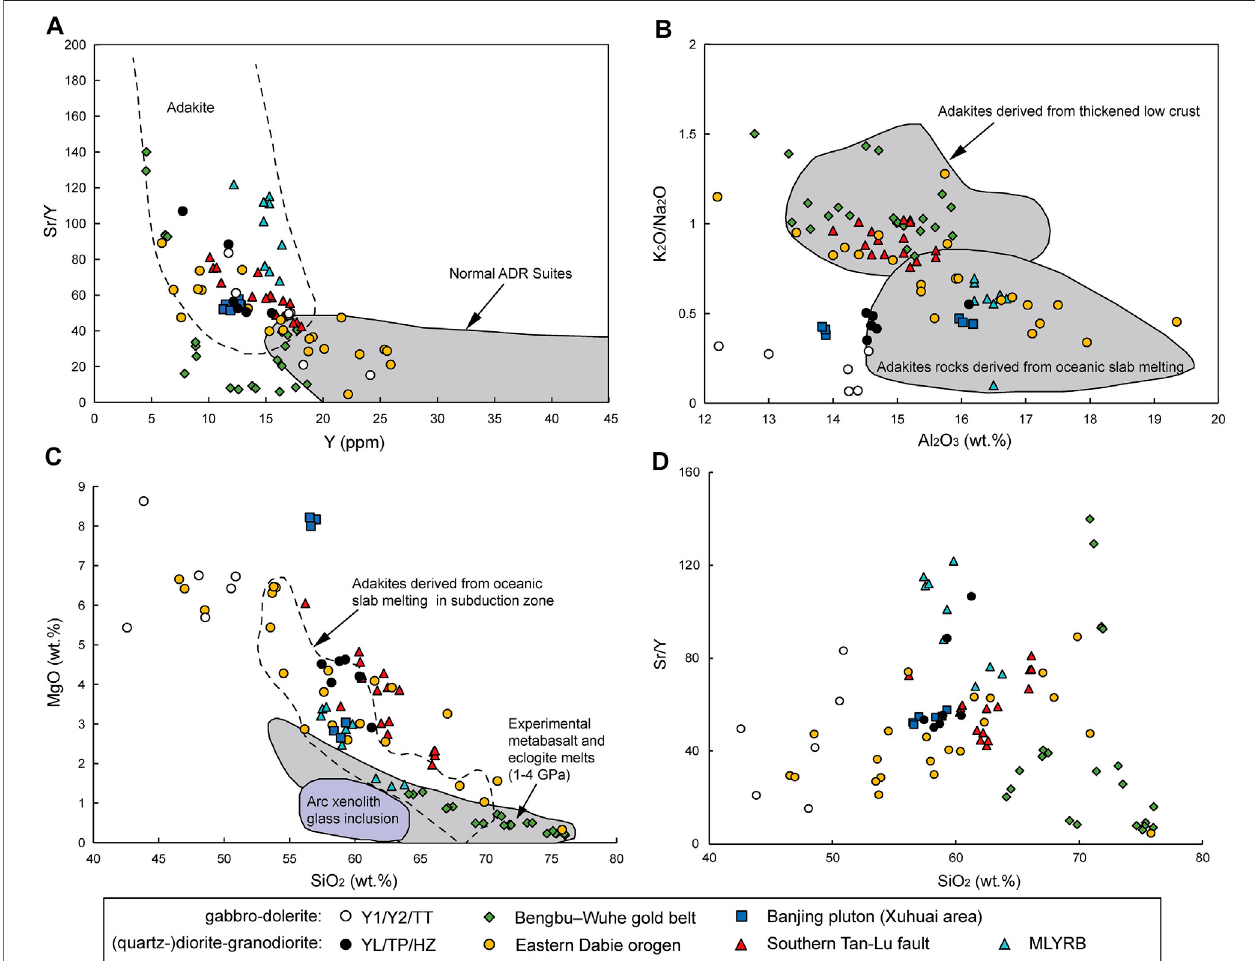
FIGURE 8 | Adakite discrimination plots for the igneous rock samples from the Huaibei-Linhuan coal fi eld: (A) Sr/Y vs. Y (after Defant and Drummond, 1993), andesites, dacites and rhyolites (ADR); (B) K 2 O/Na 2 O vs. Al 2 O 3 (after Liu et al., 2010a, and ref. therein); (C) MgO vs. SiO 2 (base map after Liu et al., 2010a, and ref. therein); (D) Sr/Y vs. SiO 2 (after Richards et al., 2012).